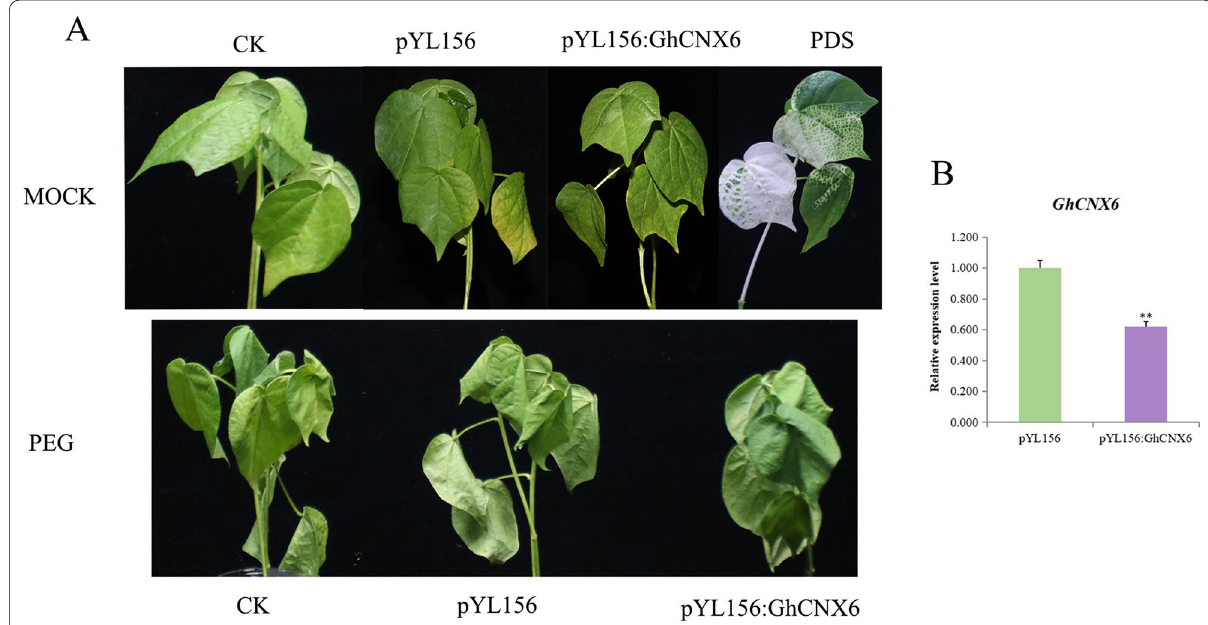
Fig. 11 Phenotype of virus-infected cotton leaves and expression analysis of GhCNX6 under PEG. A Cotton leaf phenotype after virus infection. B qRT-PCR detection of GhCNX6 under